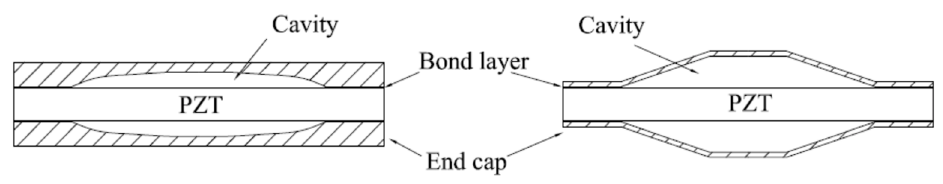
Figure 13. Structure diagrams of Moonie ( left ) and Cymbal ( right ).